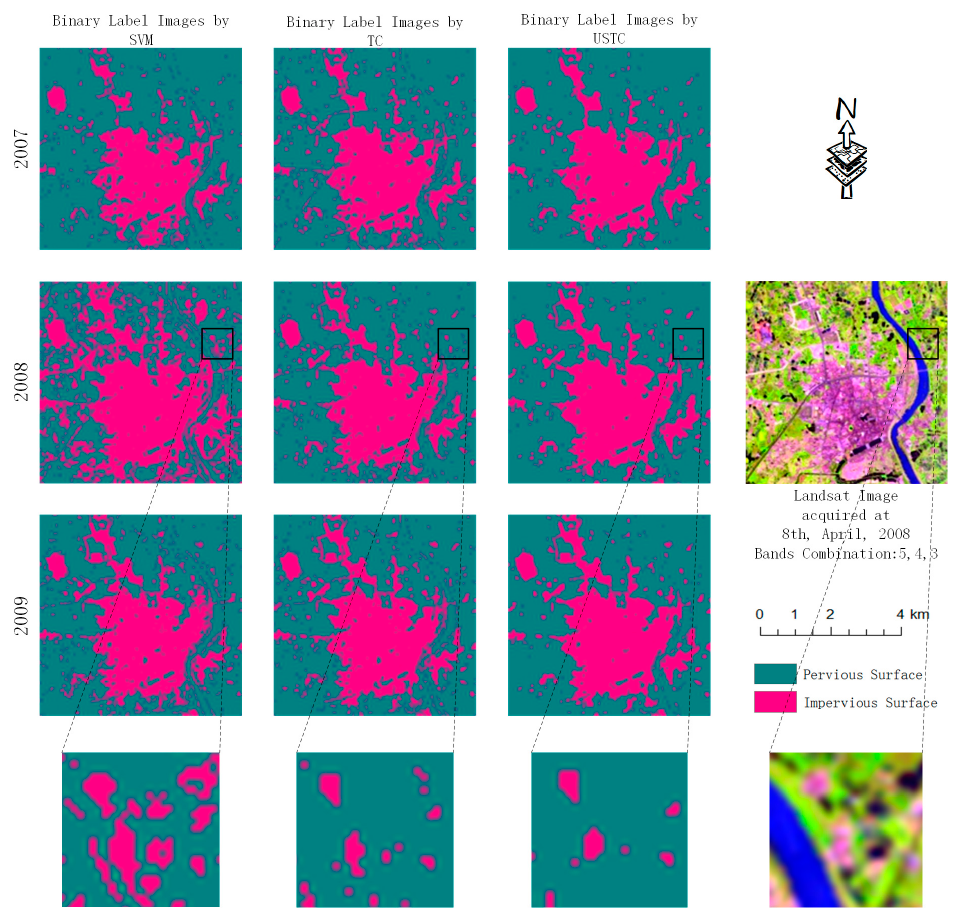
Figure 4. Comparison of three classification results in the main urban area of Huangpi district, showing the overestimation case. the overestimation